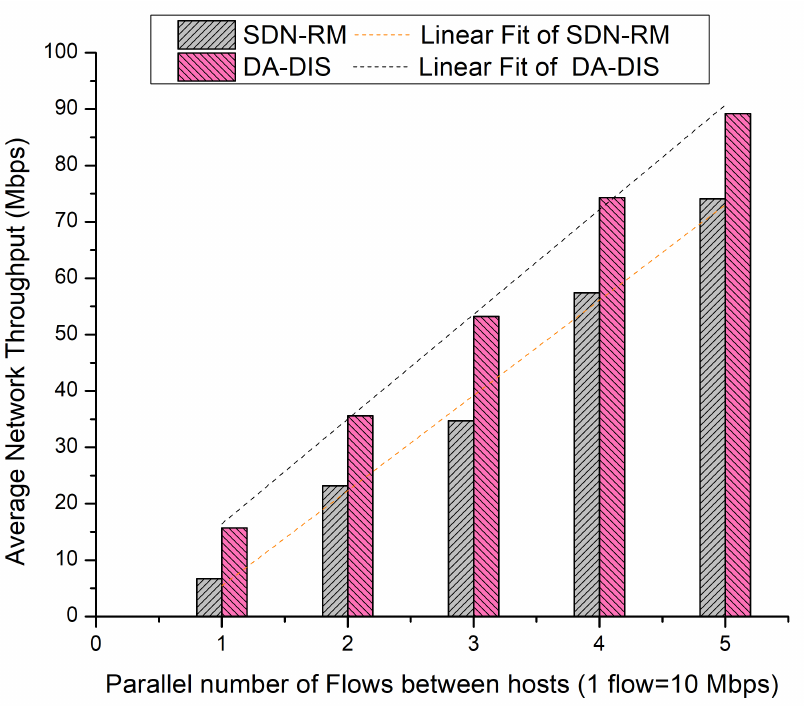
Figure 17. Throughput considering different numbers of parallel flows with one malicious switch along with E1 category